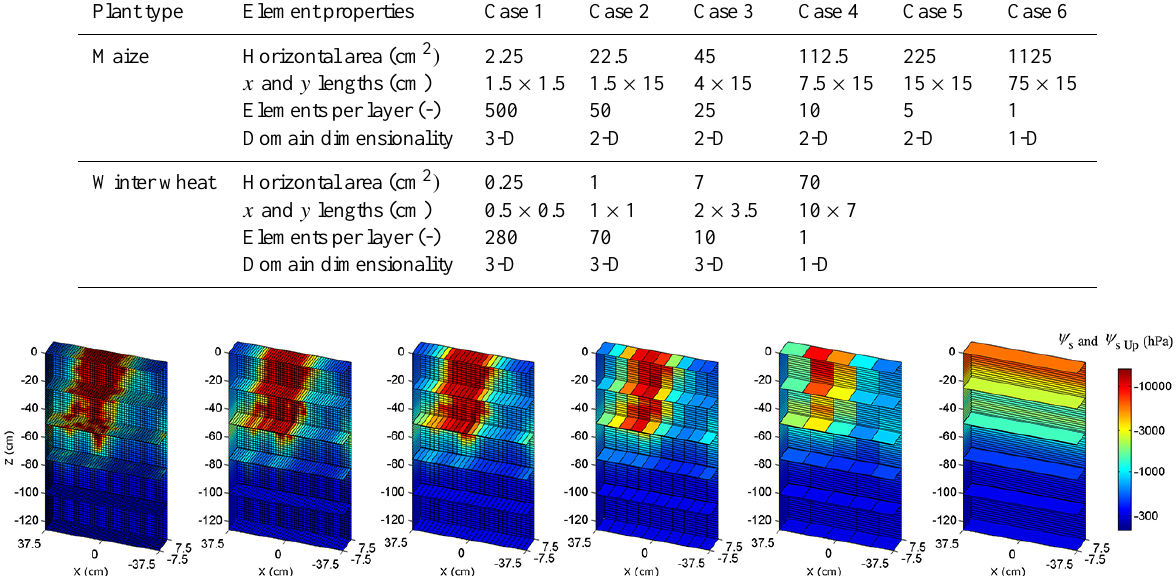
Fig. 4. Discretisations of the maize crop soil domain used for the first simplifying approach. The colour scale gives the soil water potential distribution at the end of the high-transpiration-rate scenario on silt